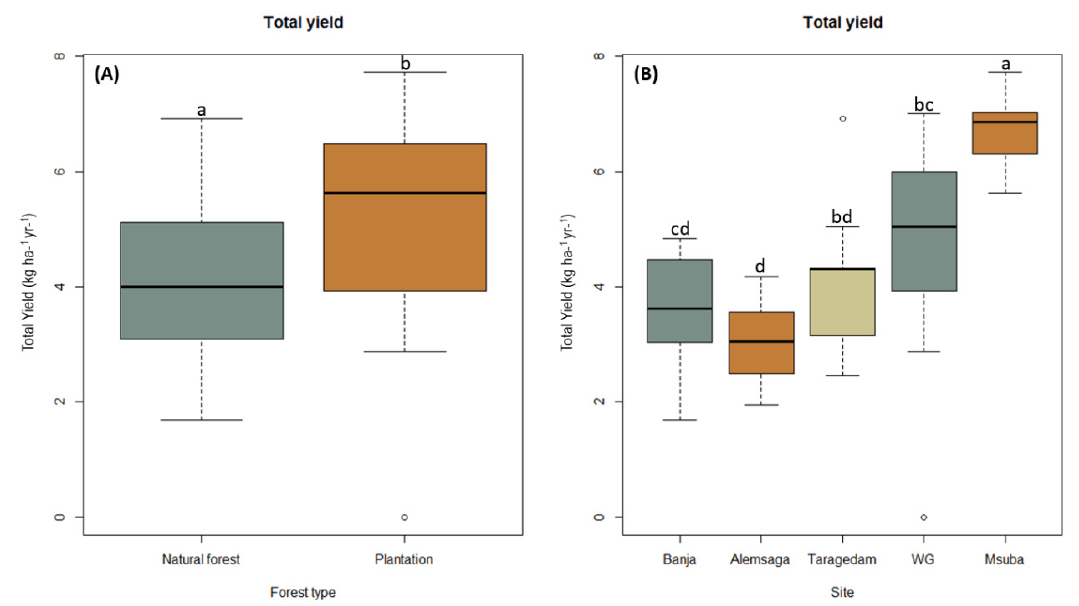
Figure 4. Production of sporocarps at five study sites in Ethiopia according to the forest type ( A ) and site ( B ). Data are presented as boxplots showing the maximum and minimum values. The bar in the box is the standard deviation of the mean. Values with the same letter are not significantly different. Msuba, Menagesha Suba; WG, Wondo Genet.